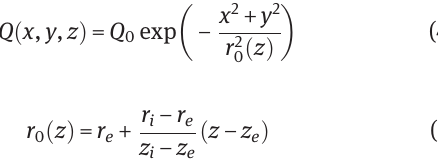
Figure 4: Double ellipsoid heat source [12].